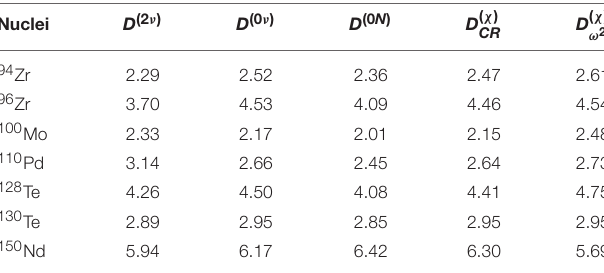
TABLE 5 | Deformation ratios D (2 ν ) , D (0 ν ) , D (0 N ) , D ( χ ) CR , and D ( χ ) parametrization with SRC1.